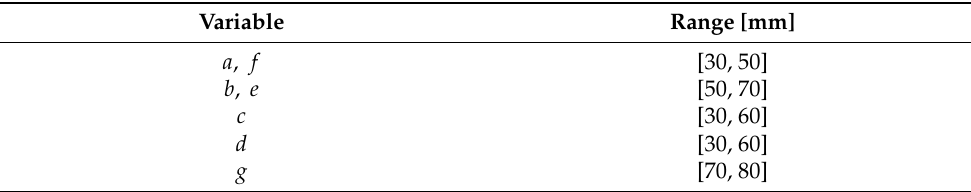
Table 4. Input data variation ranges. Source: the authors.